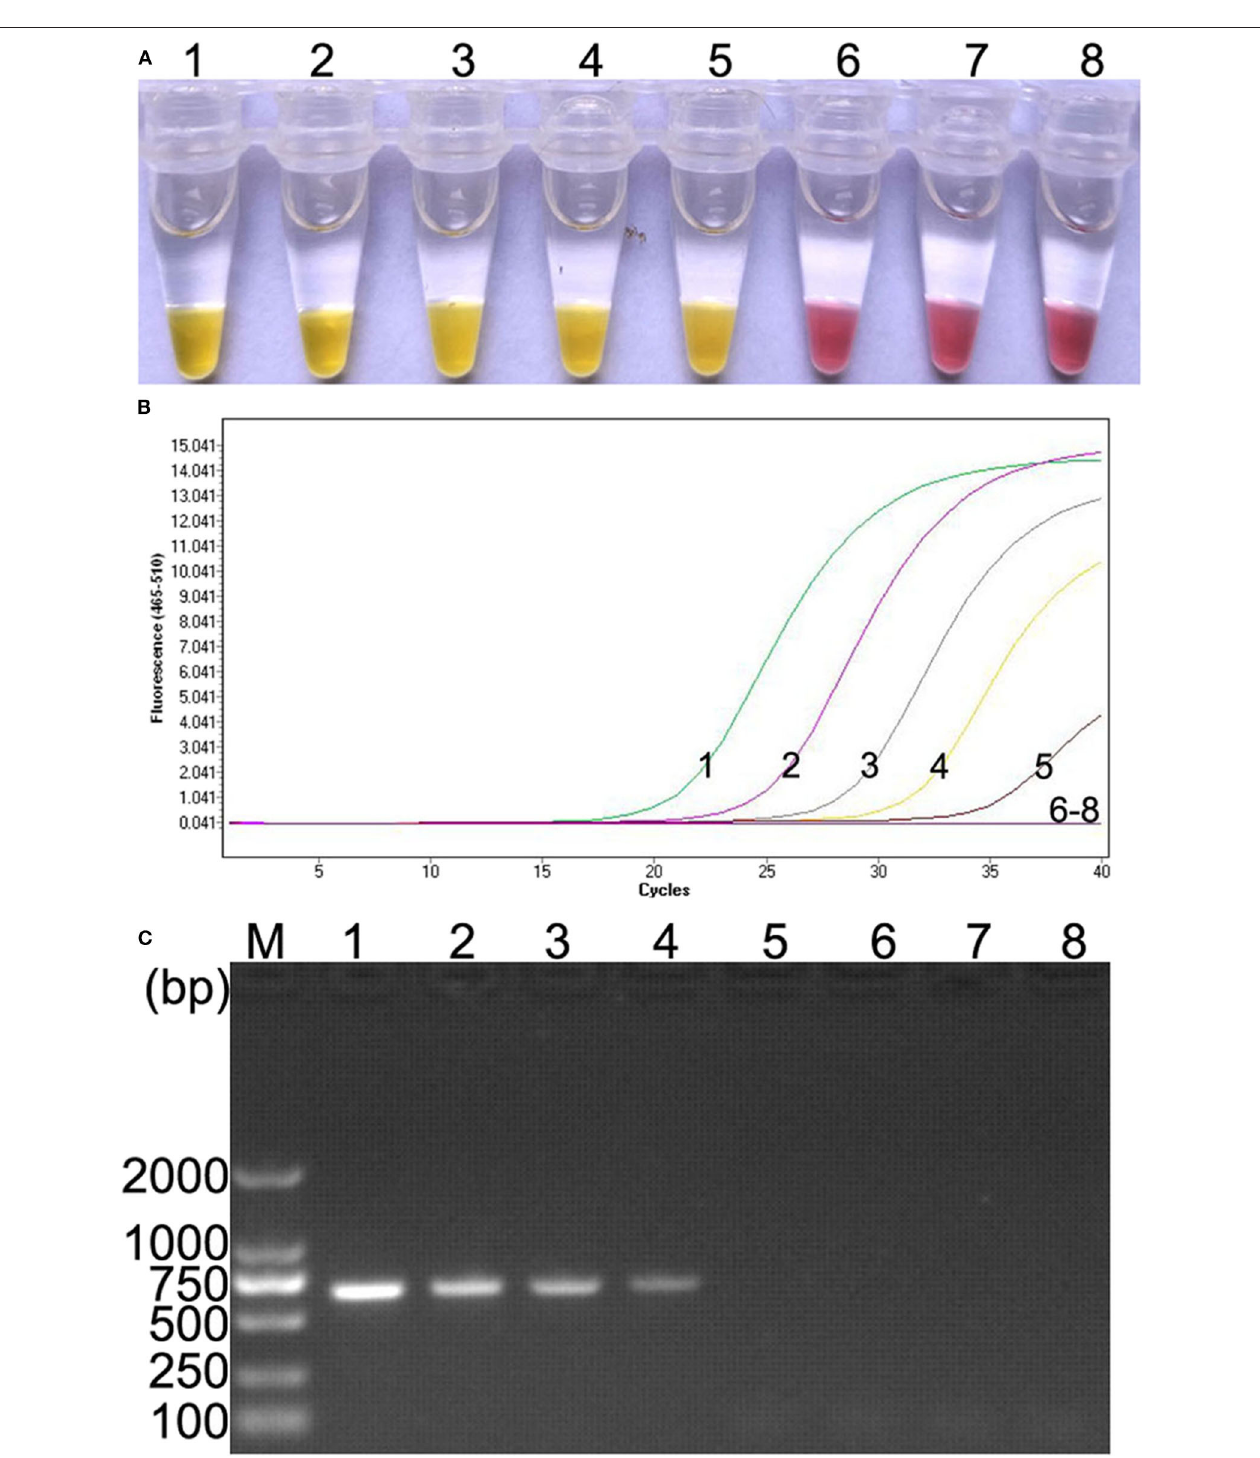
FIGURE 3 | Comparison of sensitivity of the colorimetric IMSA with qPCR and PCR. (A) Sensitivity of the colorimetric IMSA. (B) Sensitivity of qPCR. (C) Sensitivity of PCR analyzed by agarose gel electrophoresis. Tubes or lanes 1–7, ten-fold serially diluted PMD19T-capsid plasmid DNA (10 5 , 10 4 , 10 3 , 10 2 , 10 1 , 10 0 , and 10 − 1 copies). Tube or lane 8: negative control. Lane M, 2,000-bp DNA